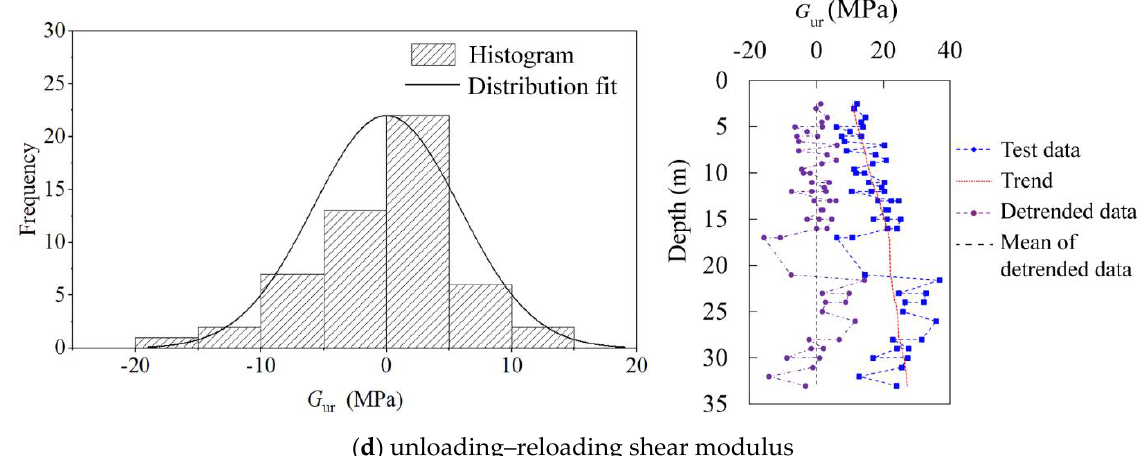
Figure 16. Histogram and the distribution fit of the detrended shear modulus.